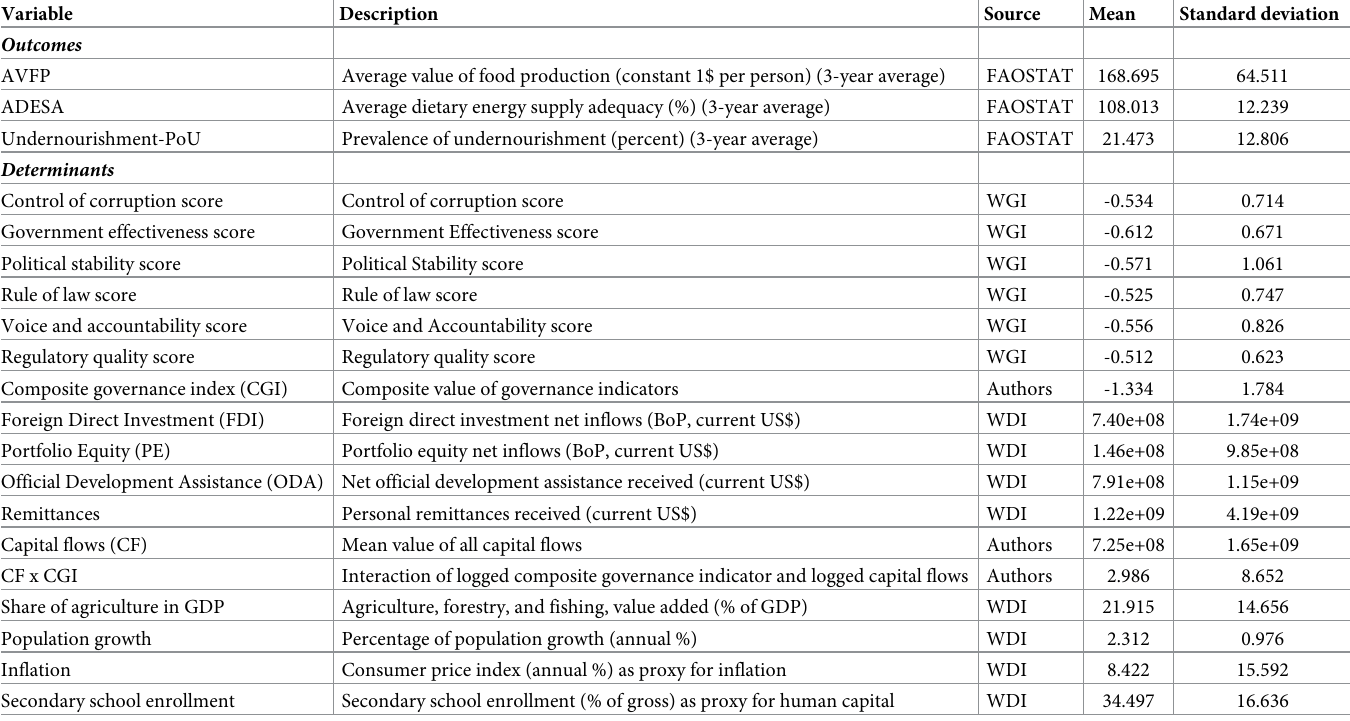
Table 1. Data sources and summary statistics of variables used in the empirical